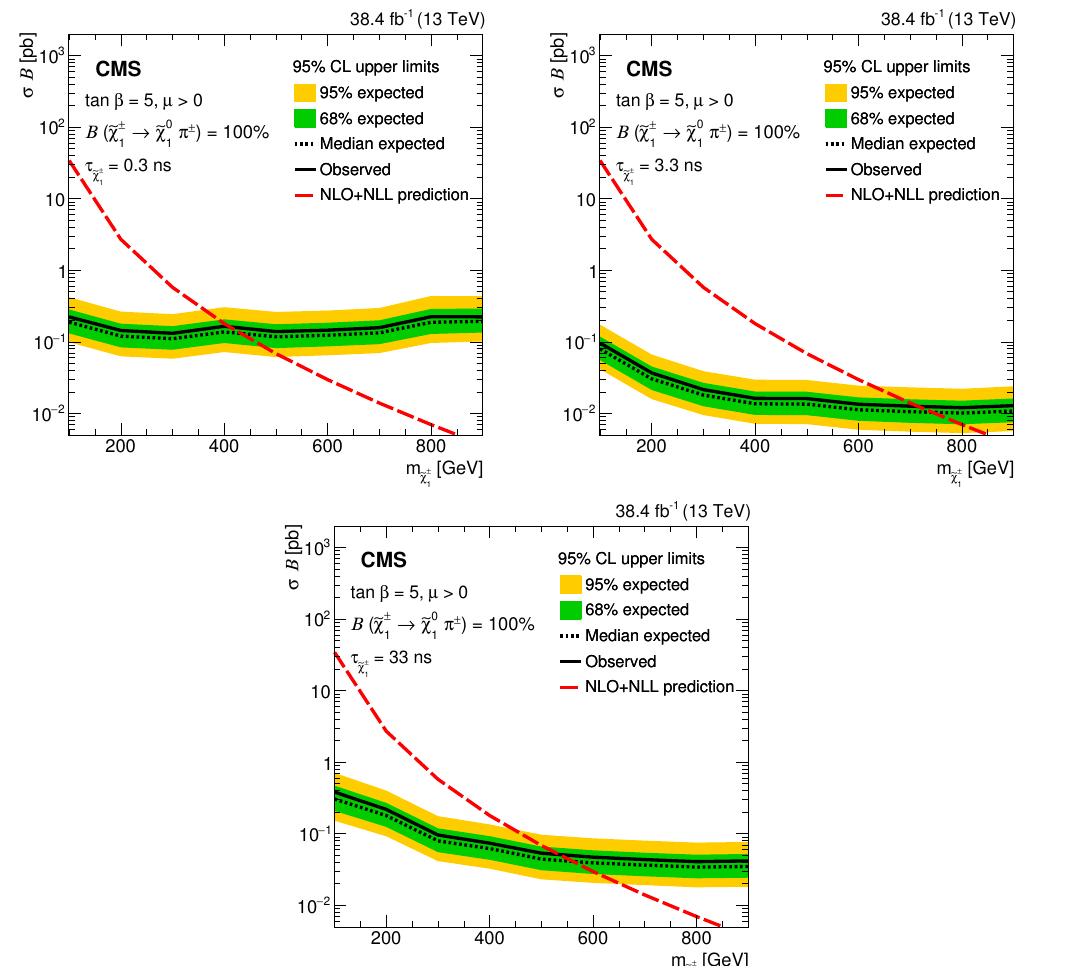
Figure 3 . The expected and observed 95% CL upper limits on the product of the cross section for direct production of charginos and their branching fraction to for chargino lifetimes of 0.33, 3.3, and 33 ns. The direct chargino production cross section includes both (cid:31) 0 (cid:31) (cid:6) and (cid:31) (cid:6) (cid:31) (cid:7) production in roughly a 2:1 ratio for all chargino masses considered. The e e 1 e 1 1 e 1 dashed red line indicates the theoretical prediction for the AMSB